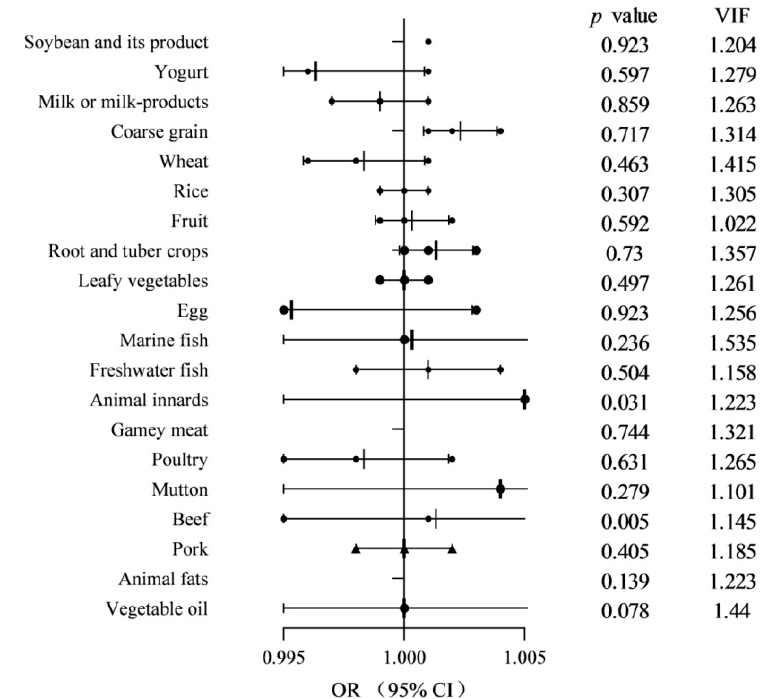
Figure 2. The multiple FFQ model for the associations of FFQ with the risk of bla NDM carrier. OR, odds ratio; VIF, variance inflation factor; 95% CI, 95%confidence interval. The dotsrepresent crude oddsratios, and the horizon lines represent 95% confidence intervals. p -valueswere obtained from the univariate logistic regression models by using the FFQ as a continuous variable.